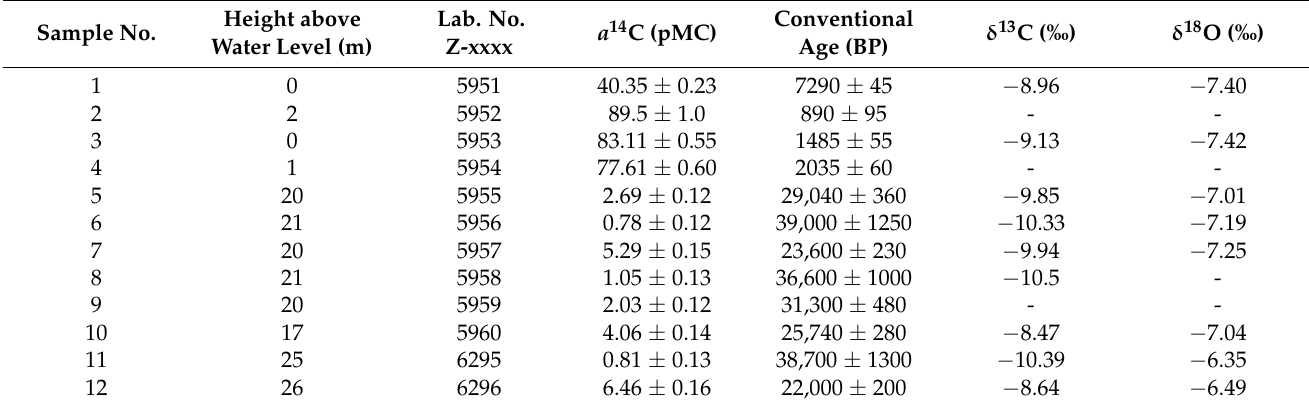
Table 2. Results of isotopic analyses of tufa samples, a 14 C, δ 13 C and δ 18 O in carbonate fraction. Sample numbers defined in Table 1 and Figure 1. Sample No.